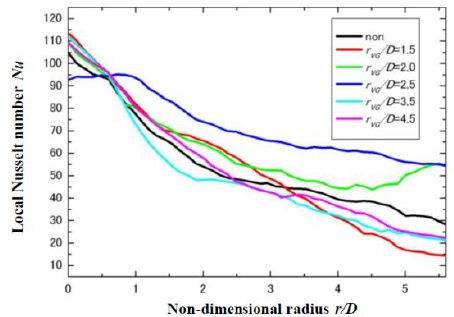
Figure 12. Effect of VG height on the averaged Nu (fixed VG location: r / D = 2.5).